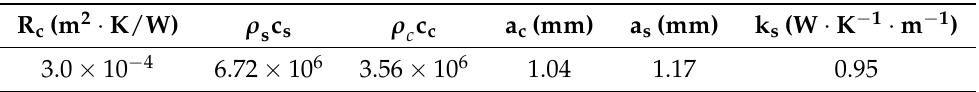
Table 3. Optimal parameters values deduced from glycerol thermal characterization tests. The units of the two volumetric heat capacities ρ c c c and ρ s c s are given in J · K − 1 · m − 3 . R c (m 2 · K /